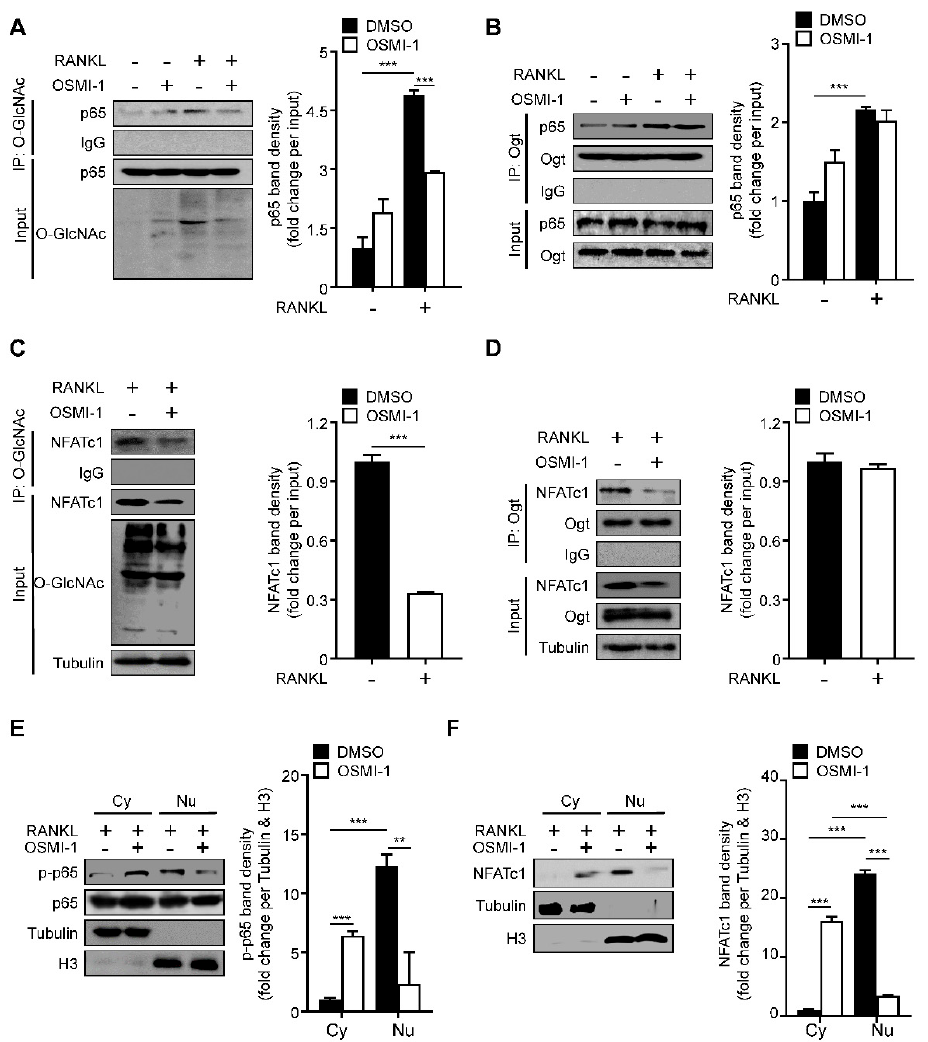
Figure 3. RANKL-induced p65 and NFATc1 O-GlcNAcylation are required for translocation to the nucleus. ( A , B ) BMMs were incubated with M-CSF (30 ng/mL) and RANKL (100 ng/mL) in the absence or presence of 5 µ M OSMI-1 for 5 min. Western blot analysis of O-GlcNAc, Ogt, or p65 was performed after immunoprecipitation using O-GlcNAc or Ogt antibodies (right panel). The immunoprecipitation band density was quantified (left panel). ( C , D ) BMMs were incubated with M-CSF (30 ng/mL) and RANKL (100 ng/mL) in the absence or presence of 5 μ M OSMI-1 for 48 h. Western blot analysis of O-GlcNAc, Ogt, or NFATc1 was performed after immunoprecipitation using O-GlcNAc or Ogt antibodies (right panel). The immunoprecipitation band density was quantified (left panel). ( E ) Cytosolic and nuclear proteins were extracted for BMMs in the absence or presence of 5 µ M OSMI-1 for 5 min to determine translocation of p-p65 (right panel). The band density was quantified (left panel). ( F ) Cytosolic and nuclear proteins were extracted for BMM in the absence or presence of 5 µ M OSMI-1 for 48 h to determine translocation of NFATc1 (right panel). The band density was quantified (left panel). Statistical data are presented as the means ± S.E.M. (** p < 0.01 and *** p < 0.001, as measured by Student’s t